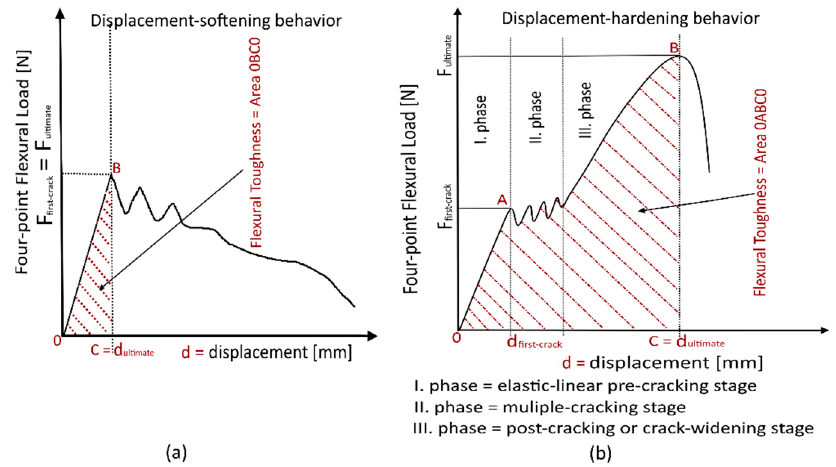
Figure 7. Flexural load – displacement behavior of textile reinforced concrete composite under four-point flexural test: ( a ) displacement-softening behavior; ( b ) displacement-hardening behavior.